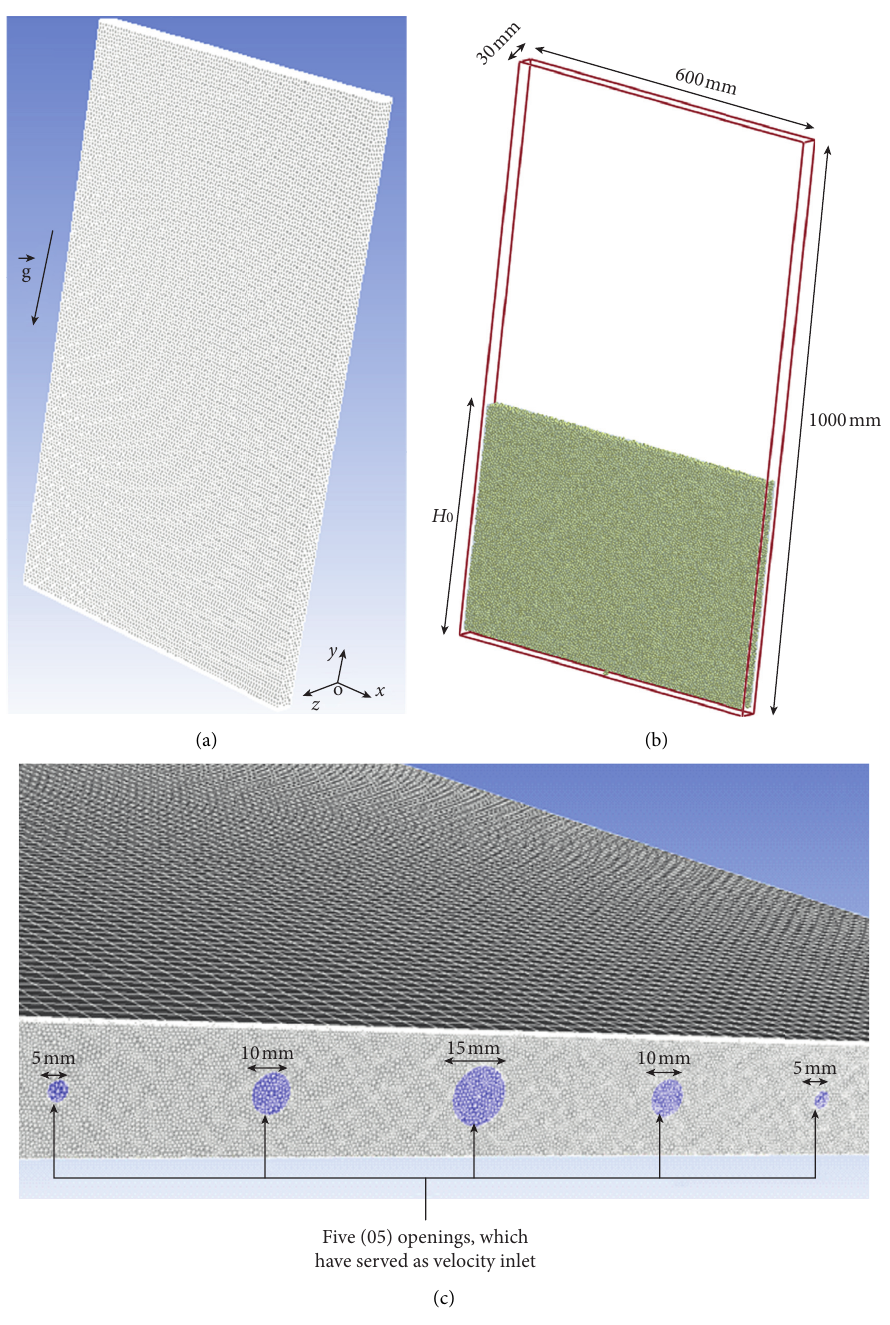
Figure 3: (a) ICEM grid, (b) simulation domain with EDEM particles, and (c) inlet holes at the base of the